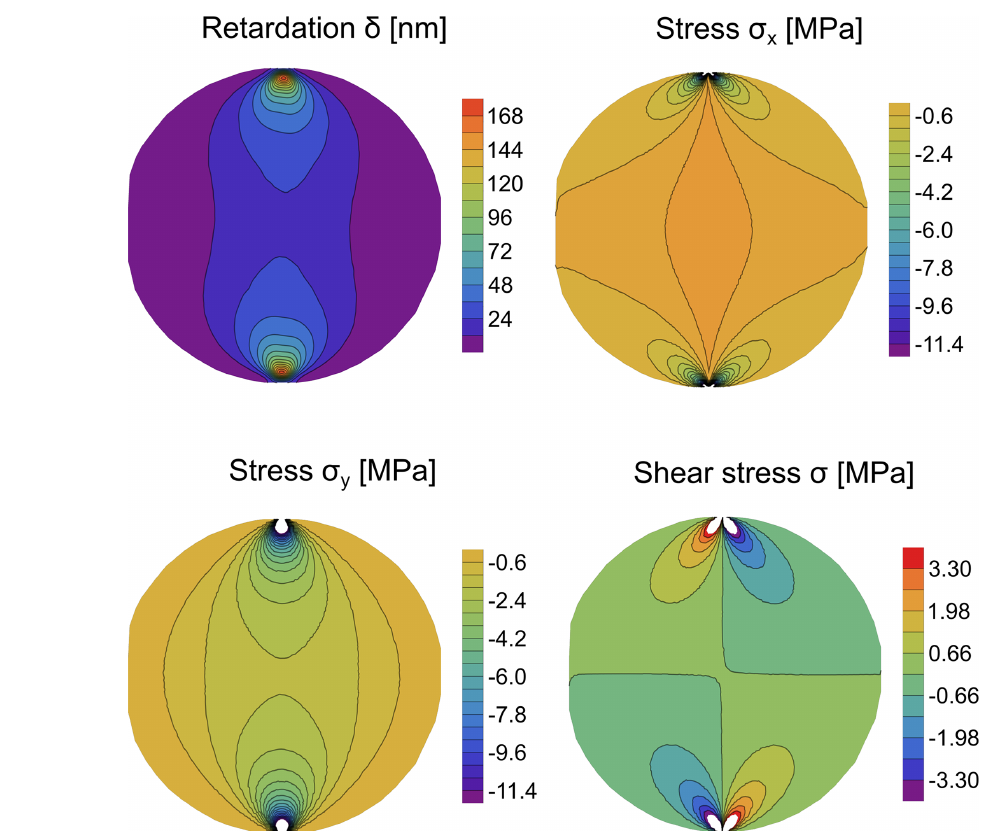
Figure 7. Example of measured retardation δ values and simulated stresses σ 11 , σ 22 and σ 12 for a loading direction of φ = 45 ◦ and a load of F = 10N.